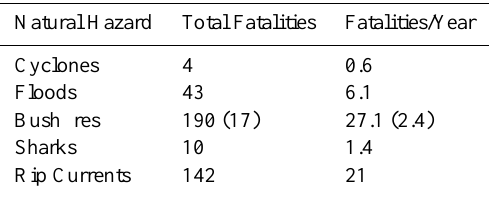
Table 2. Average number of fatalities per year attributed to different natural hazards in Australia based on overlapping datasets for the period 2004–2011. Bushfire statistics in parentheses do not include the bushfire event of 9 February